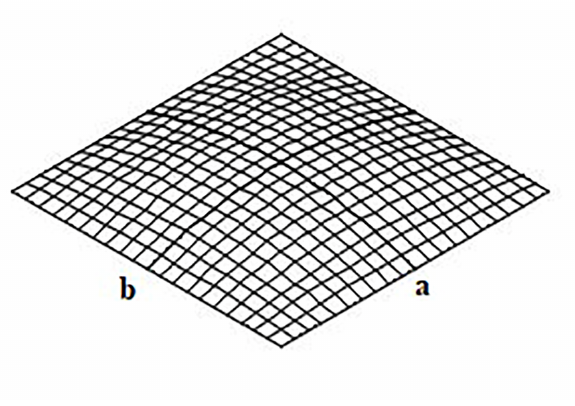
Figure 1: Funicular surface on rectangular plan